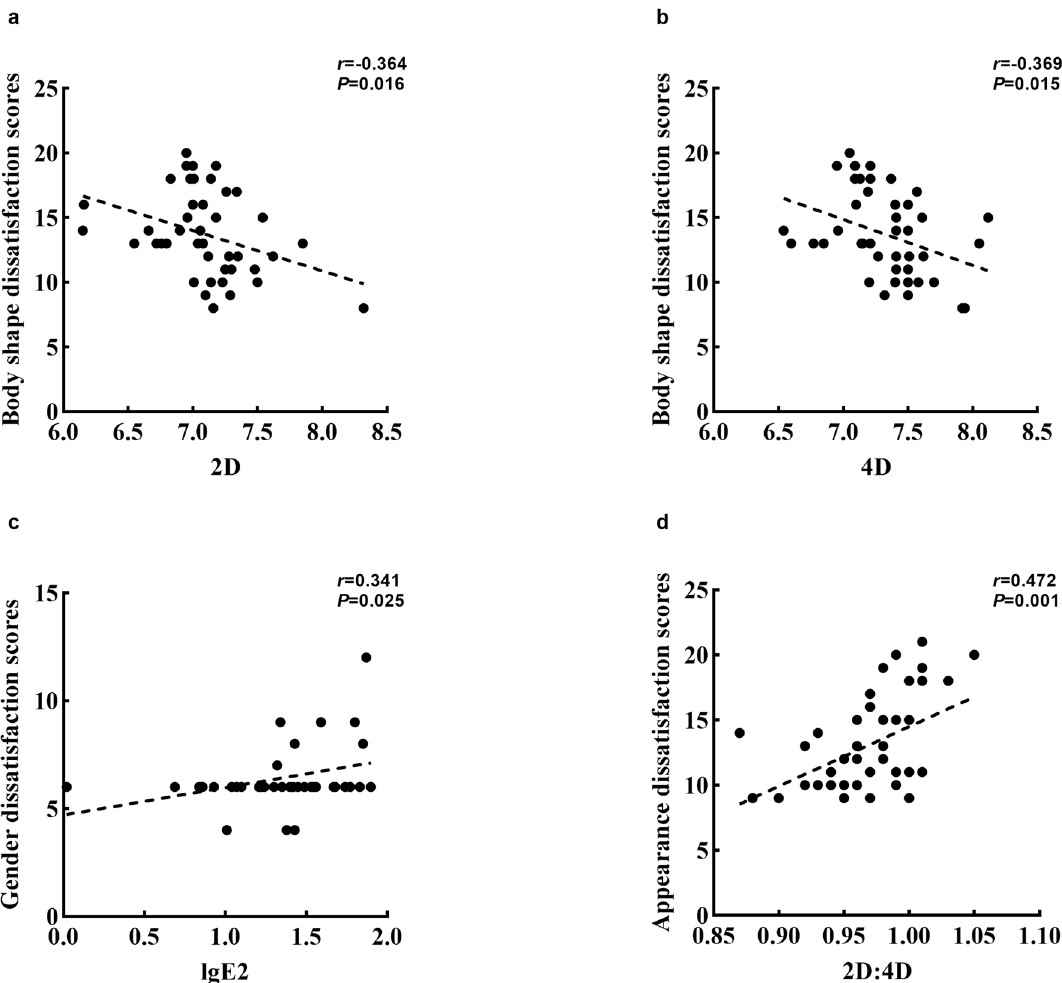
Figure 3. The associations between digit ratio (2D:4D) and body image dissatisfaction among boys with different puberty developmental stages. ( a ) The association between 2D and Body shape dissatisfaction scores among boys with first spermatorrhea; ( b ) the association between 4D and body shape dissatisfaction scores among boys with first spermatorrhea; ( c ) the association between lgE2 and Gender dissatisfaction scores among boys with first spermatorrhea; ( d ) the association between 2D:4D and Appearance dissatisfaction scores among boys with first